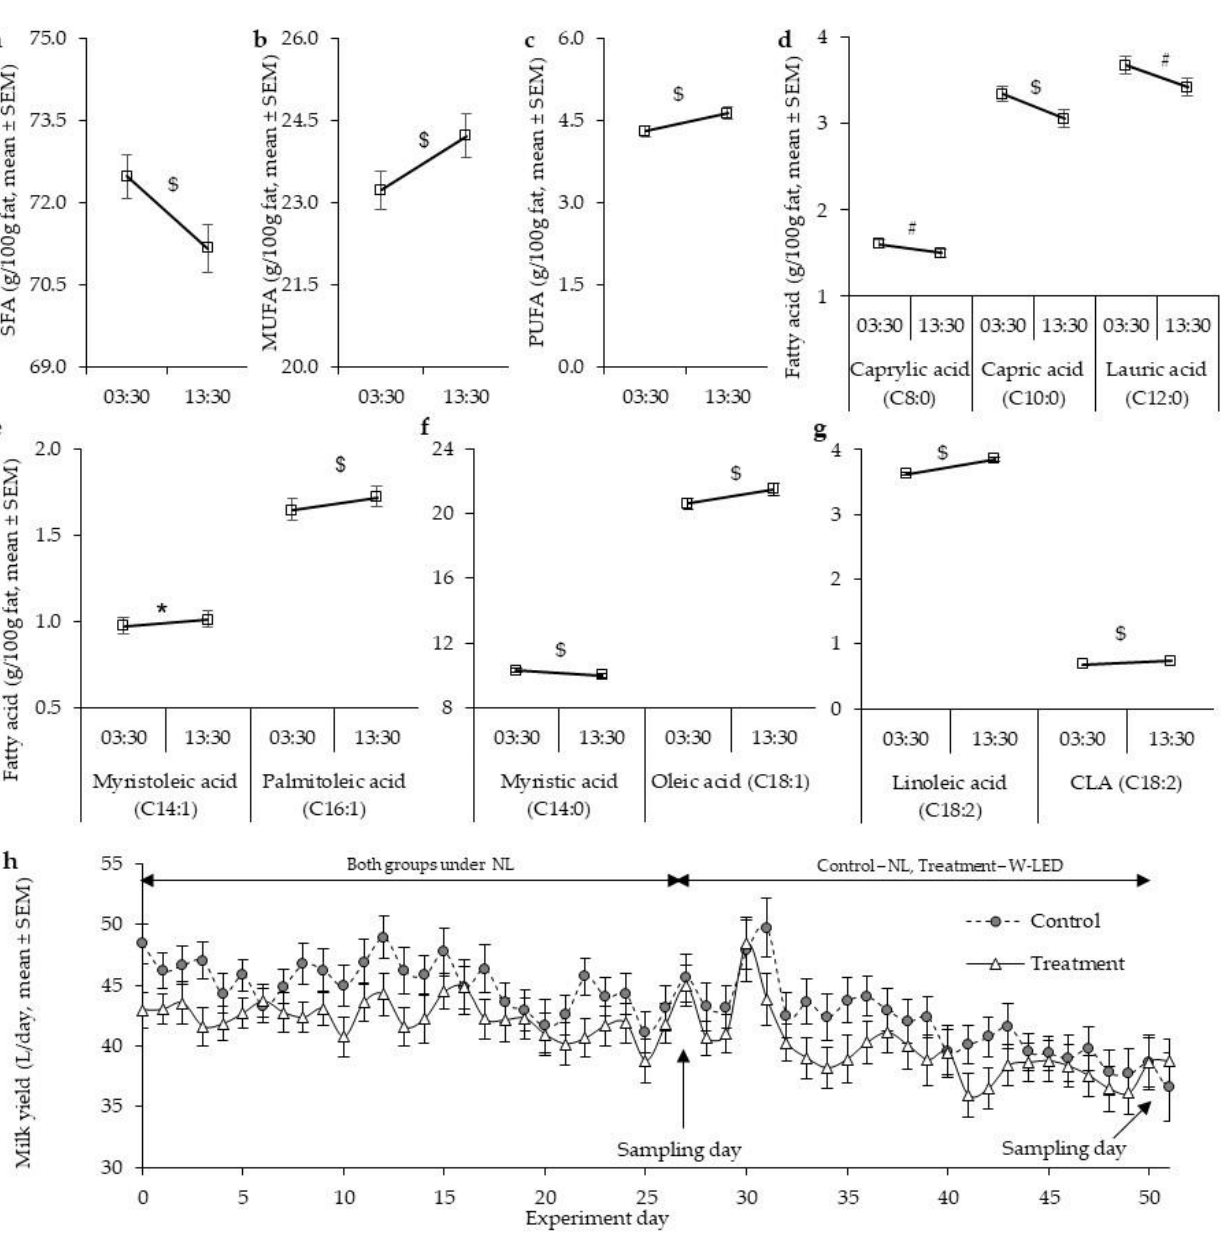
Figure 3. The effects of milking hour on milk fat composition under natural light baseline conditions for cows treated with W-LED and the control group; and the effect of illumination condition on milk yield (h). We detected the level of saturated (a), monounsaturated (b), and polyunsaturated (c) fatty acids, caprylic, capric, and lauric fatty acids (d), mysritoleic and palmitoleic fatty acids (e), myristic and oleic fatty acids (f), and linoleic and conjugated linoleic fatty acids (g). The data are presented as mean ± standard error. Control, n = 15; treatment, n = 18. NL, natural light; SFA, saturated fatty acids; MUFA, monounsaturated fatty acids; PUFA, polyunsaturated fatty acids; CLA, conjugated linoleic acid.*, p < 0.05; #, p < 0.01; $, p < 0.001, between milking hours, by Wilcoxon non-parametric test.